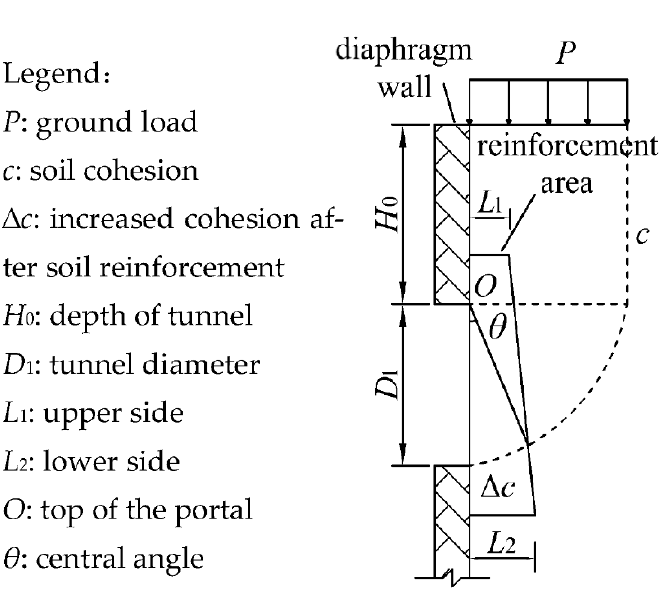
Figure 5. The stability calculation model of the tunnel portal with the trapezoidal freezing soil mass.